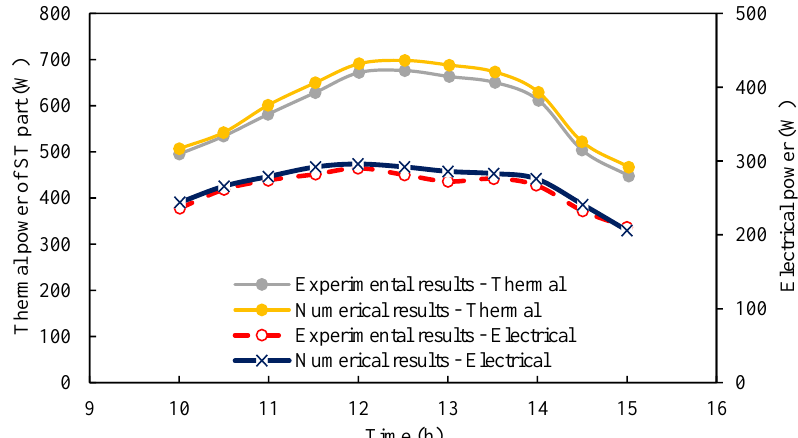
Fig. 4 Comparing the thermal and electrical power calculated by using the numerical model with the experimental data reported by Suresh et al. [15]